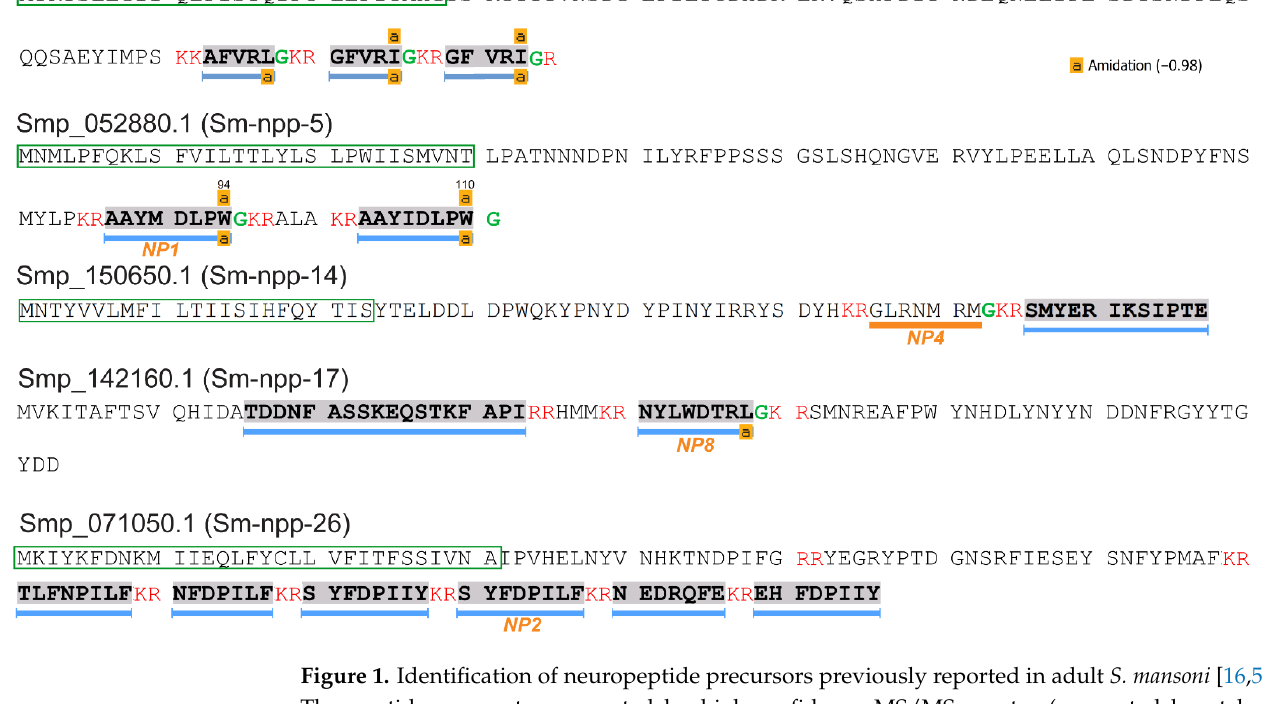
Figure 1. Identification of neuropeptide precursors previously reported in adult S. mansoni [16,59]. The peptide segments, supported by high-confidence MS/MS spectra (supported by at least 5 consecutive b or y ions), are displayed in grey shade and underlined with blue bars. Predicted signal peptides are shown in a green frame; cleavage sites are in red font; glycine residues available for C-terminal amidation are in green font. Putative neuropeptides employed in behavioural bioassays are underlined in orange with their corresponding descriptions.